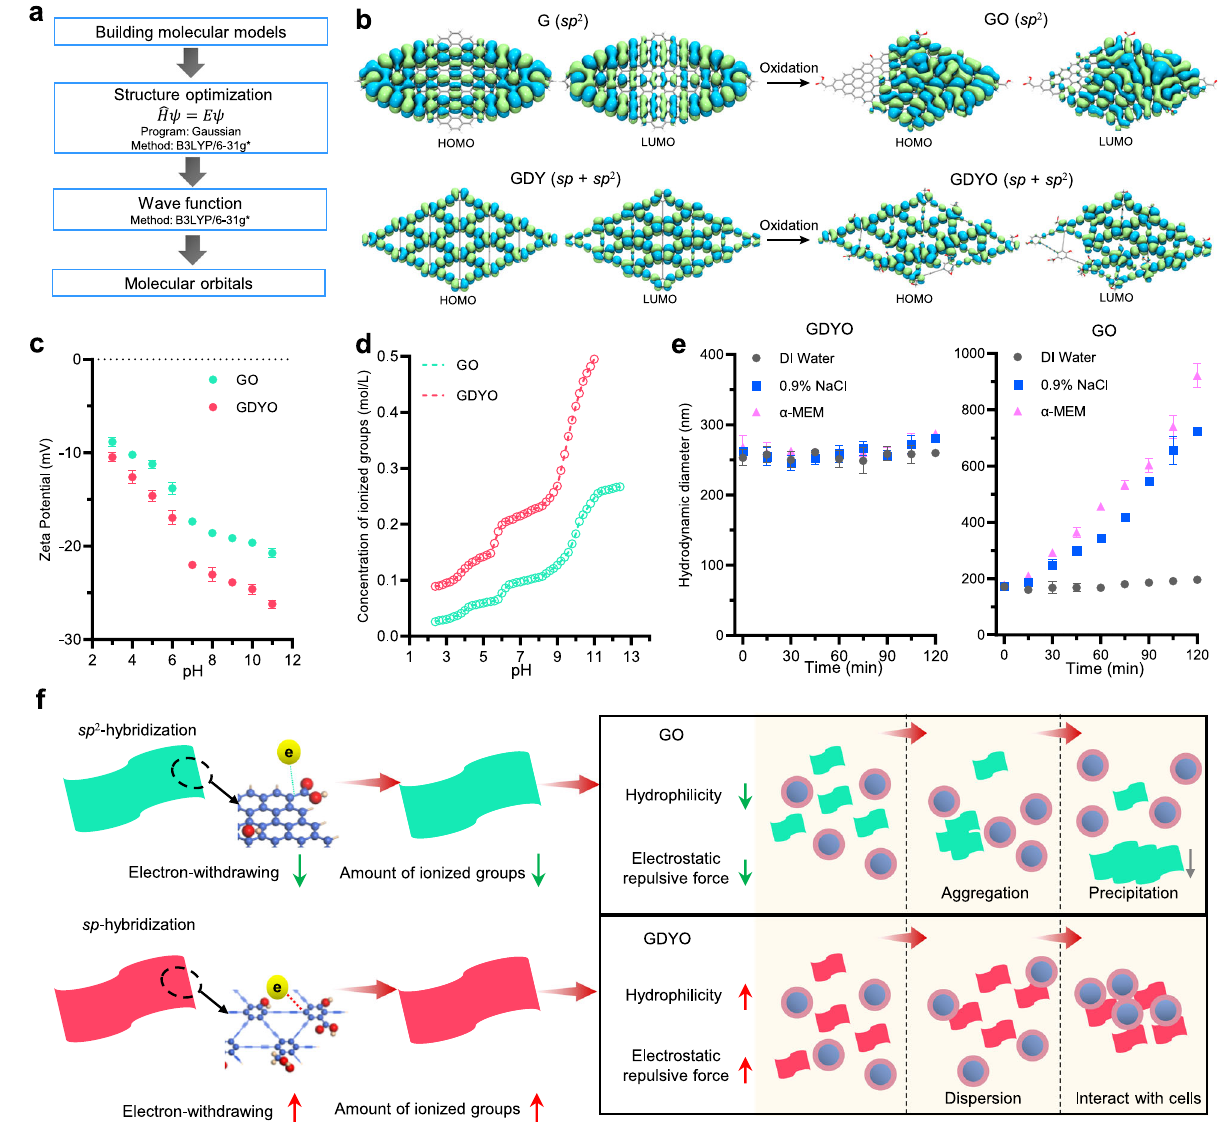
Fig. 3 | GDYO displayed better dispersion potential than GO in culture media. a Work fl ow of molecular orbital calculation. b Calculated HOMO and LUMO molecular orbitals of GO and GDYO. c Zeta potential of GO and GDYO nanosheets at different p H values. n =3 independent experiments . d Concentration of ionized groups of GO and GDYO nanosheets at different p H values. e Hydrodynamic